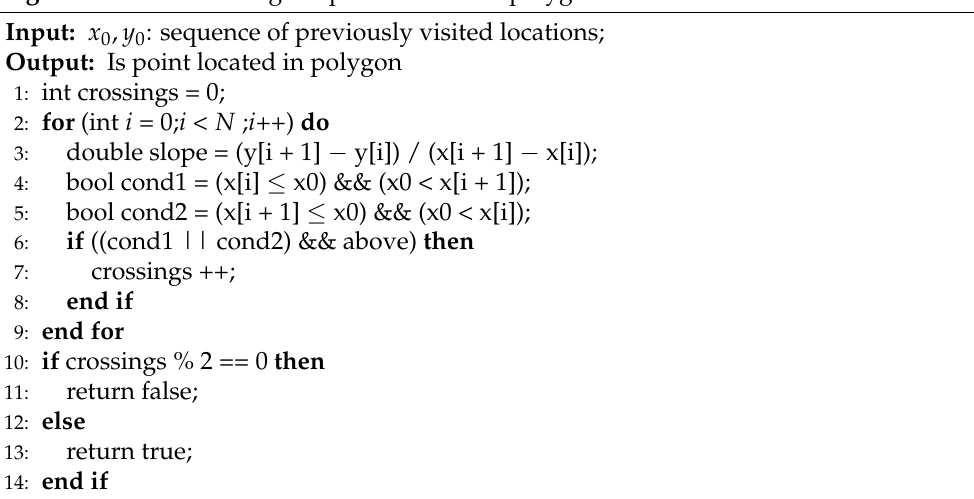
Algorithm 1 Determining if a point is inside a